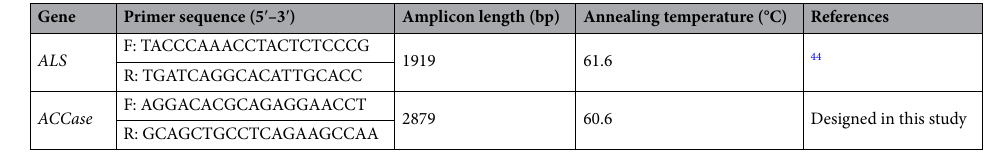
Table 6. Primer sequences used in this